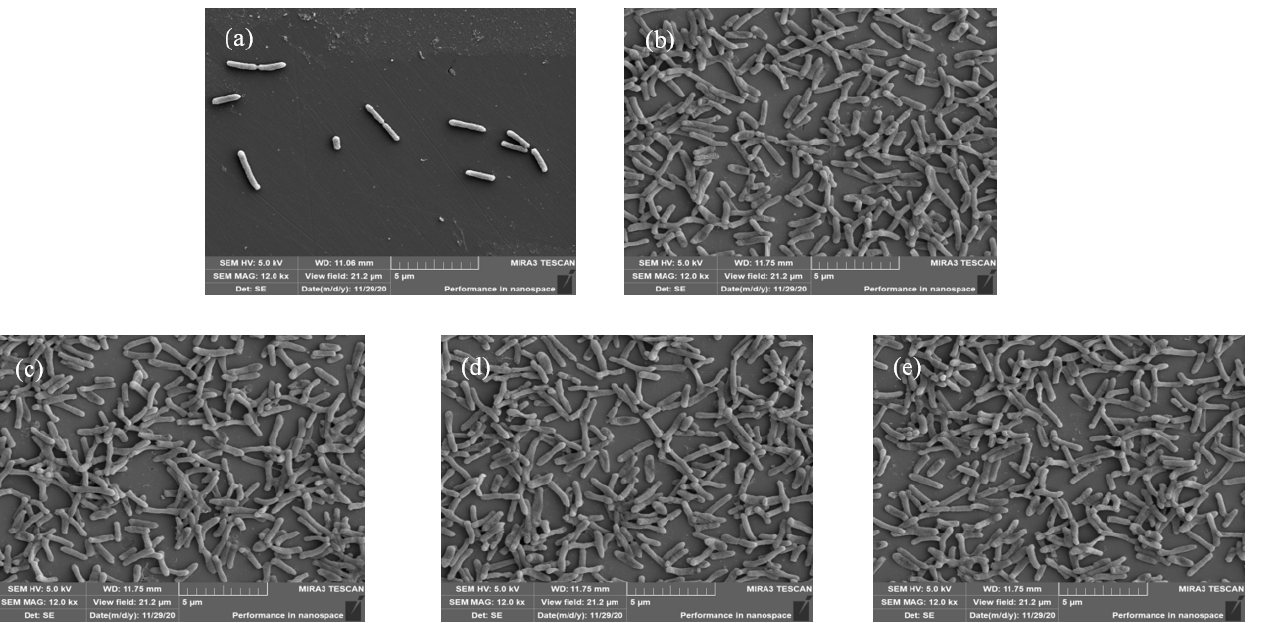
Figure 6. Scanning electron micrographs of L. monocytogenes and P. aeruginosa biofilms in mono- and dual-species biofilms in the chicken juice at 24 h. Note: The mono-species biofilms of L. monocytogenes (a) and P. aeruginosa (b) with the initial inoculum concentration of 3 log CFU/mL; dual-species biofilms of L. monocytogenes and P. aeruginosa with the ratio of 1:1 ( c ); 1:10 ( d ); and 10:1 ( e ).